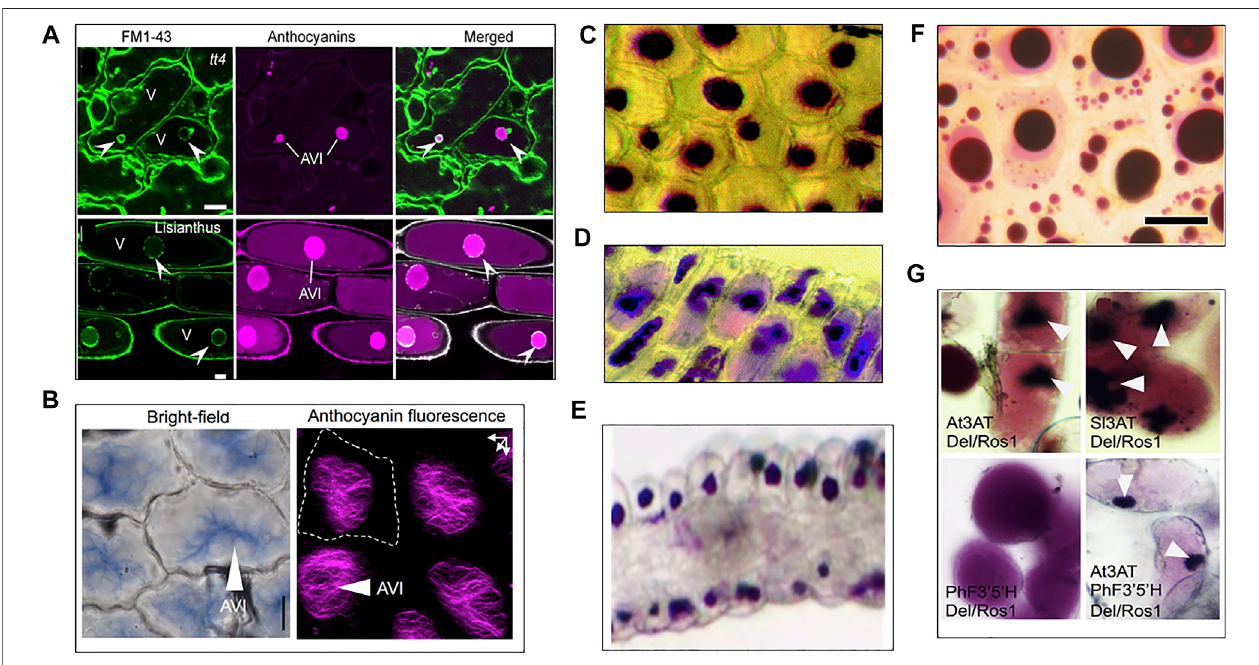
FIGURE2| DiversityofAVImorphologyacrossplantspecies. (A) ConfocalmicrographsofmembraneboundAVIsinArabidopsis(top, tt4 )andLisianthus(bottom), membrane fl uorescently marked with FM1-43 dye. (Chanoca et al., 2015). (B) AVIs found in Delphinium grandi fl orium sepal cells (Kallam et al., 2017). (C) AVIs in carnation (Markham et al., 2000) (D) AVIs in Lisianthus (Markham et al., 2000). (E) granular AVIs in Catharanthus roseus (Deguchi et al., 2020). (F) Vesicle-shaped AVIs enriched inacylatedanthocyaninsvisibleingrapevinecells(Mizunoetal.,2006). (G) AVIsformationintobaccoafteraromaticacylationofanthocyanins:topleftand right,AVIsvisibleintobaccocallusexpressingAnthocyanininducingtranscriptionfactorsandacyltransferasesfrom Arabidopsis andtomato(AT3ATandSl3AT).Bottom left, tobacco callus expressing anthocyanin inducing transcription factores and Petunia Flavonoid-3 ′ 5 ′ -Hydroxylase and shows no AVIs. Bottom right, tobacco callus expressing anthocyanin inducing transcription factors, Arabidopsis acyl transferase and Petunia Flavonoid-3 ′ 5 ′ -Hydroxylase accumulates AVIs (Kallam et al., 2017).